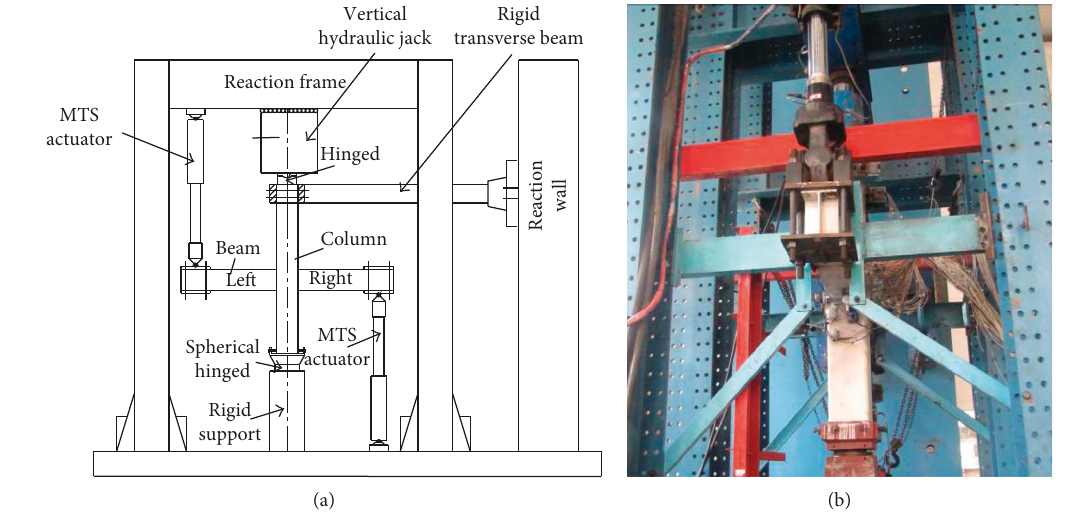
Figure 4: Test setup. (a) Diagram of the loading device. (b) Lateral brace of the steel beams.